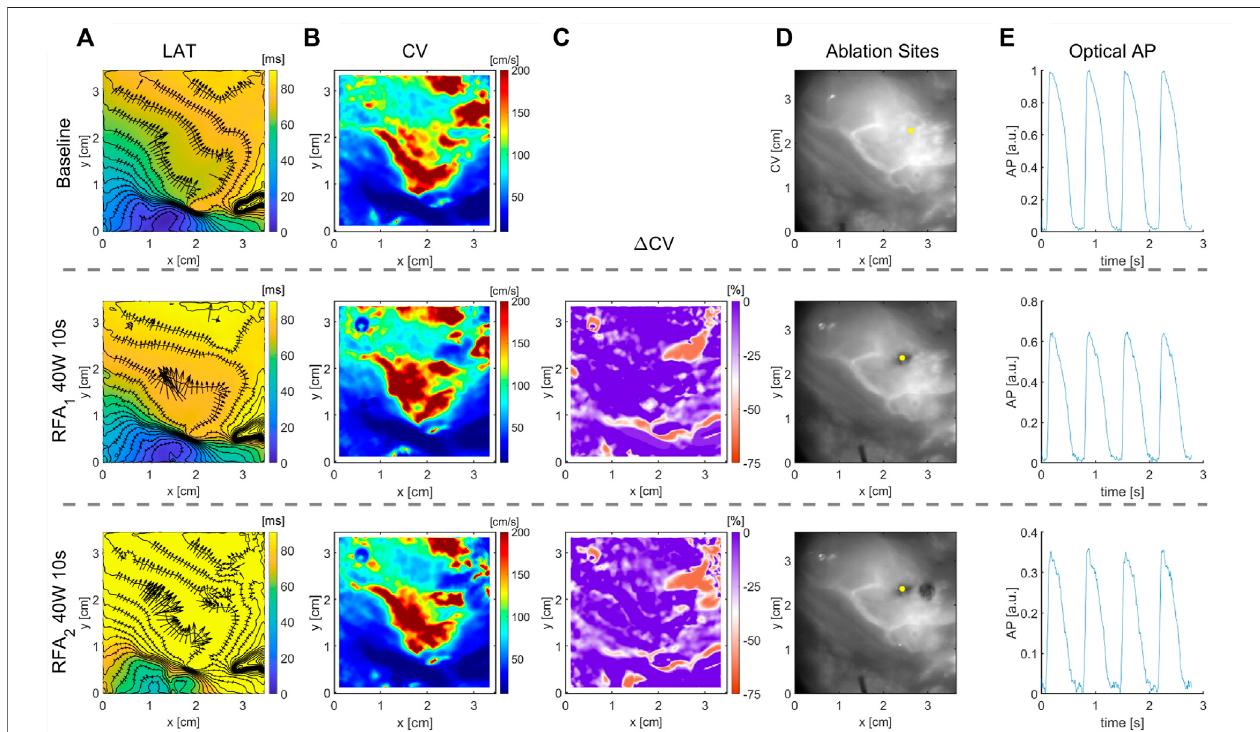
FIGURE 5 | Optical mapping on whole explanted human heart for quanti fi cation of RFA-created lesion. RFA was performed on ventricle ’ s epicardial side in two steps, termed RFA 1 andRFA 2 ,withpowerset to40 W for10 sineach step. (A) LATtimemapsshowwavefrontpropagation slowingintheupper rightregionwherethe ablationwasperformed. (B) CVmapsbeforeandafterablationshowcharacteristicCVslowingintheablatedregion. (C) ChangeinCVobtainedastherelativedifference after and before ablation clearly outlines the red area where ablation was performed of a distinct CV decrease. (D) Black and white images captured using the optical mapping camera illustrate ablated regions. (E) Optical AP traces from a pixel marked with a yellow dot in D normalized before ablation. The traces show the relative change in fl uorescence corresponding to transmembrane voltage change. The color bar range in all fi gures is set from the 5th to 95th percentile, except for Δ CV maps ’ upper boundary that was set to zero. Radius of 4 pixels (1.1 mm), in the CM, was used for CV calculation.